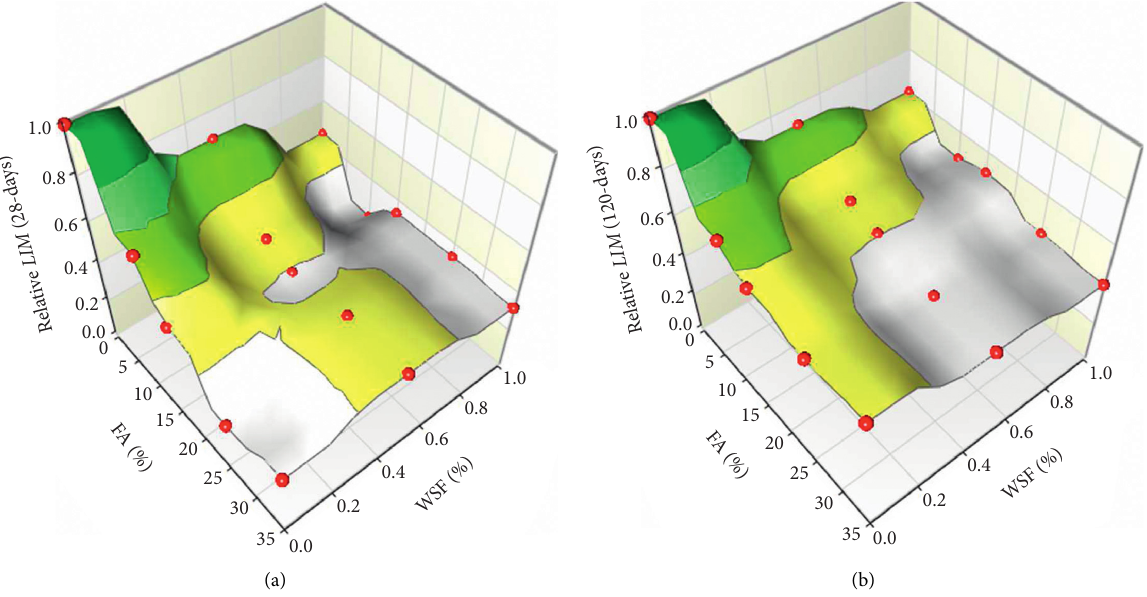
Figure 26: Relationship between FA, WSF, and relative loss in mass- LIM values of HSC: (a) 28 days and (b) 120